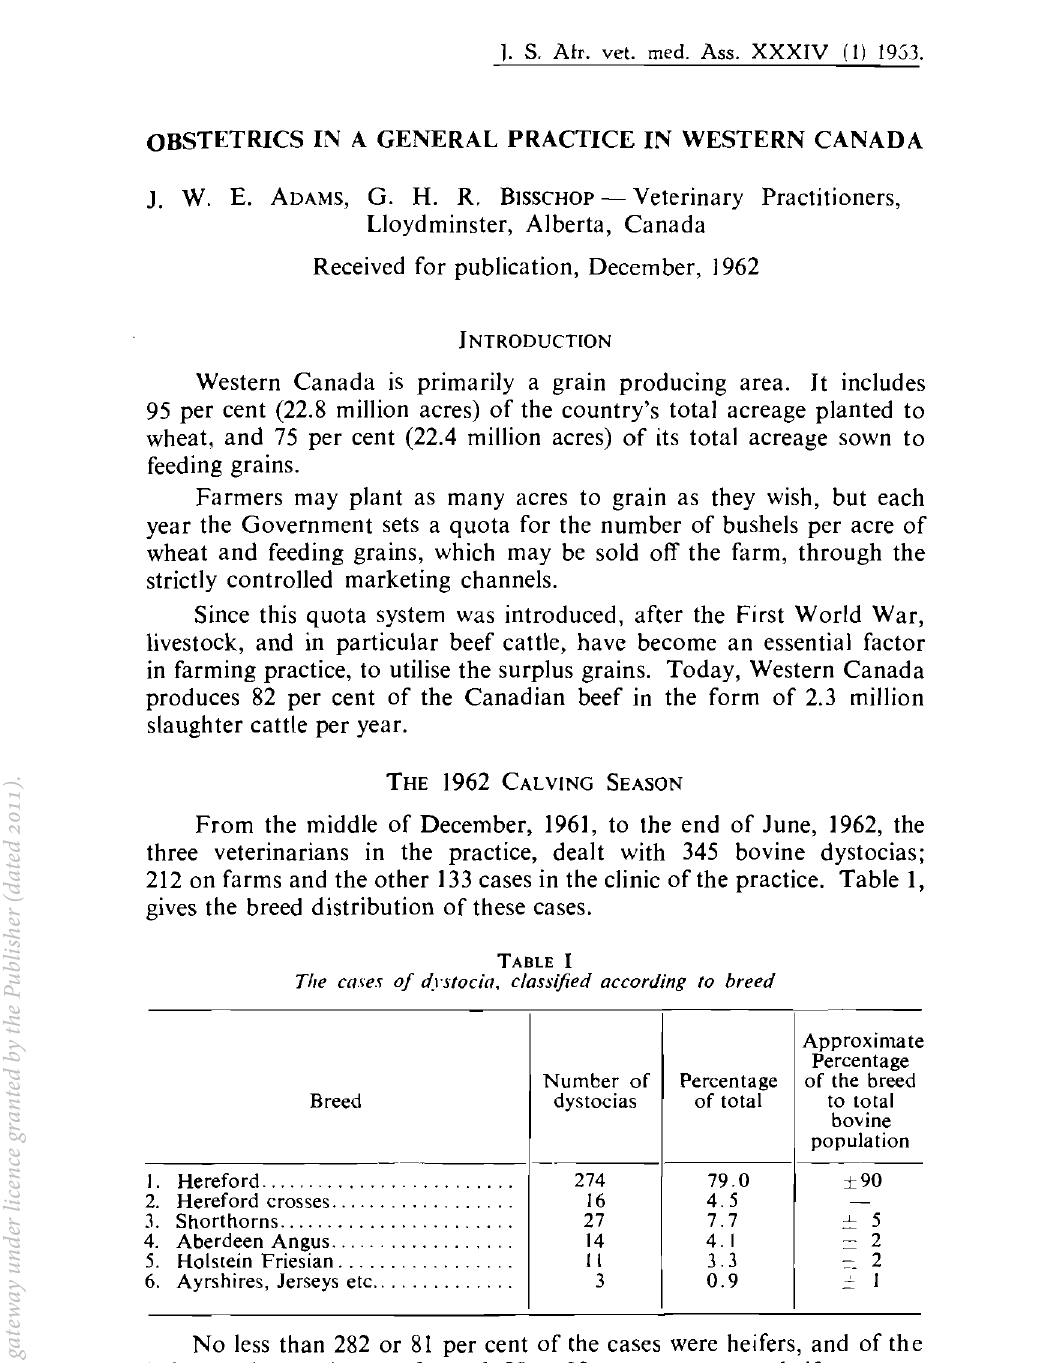
TABLE I The cases of dystocia, classified according to